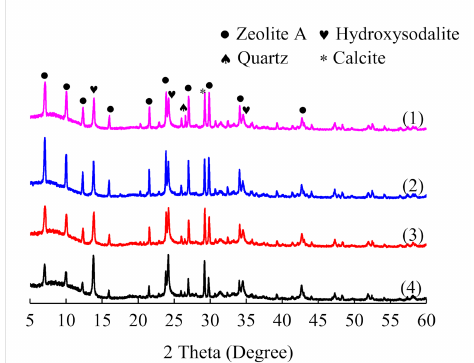
Figure 3. XRD of zeolite A synthesized at di ff erent solid-phase alkali fusion temperatures. Reaction conditions: m(NaOH) / m(CGFS) = 1.2, liquid / solid ratio 5.5 mL / g, hydrothermal reaction temperature 373 K, hydrothermal reaction time 12 h. Solid-phase alkali fusion temperature / K: (1) 873, (2) 823, (3) 773, and (4)